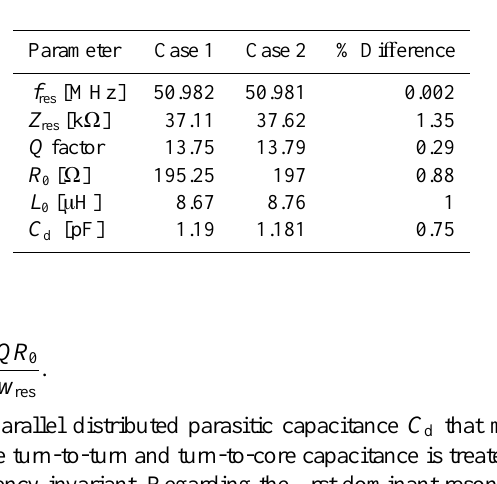
Table 2. Computed and measured parameters using resonance fre- quency definitions Case 1 and 2 for a micro coil with 33 turns.